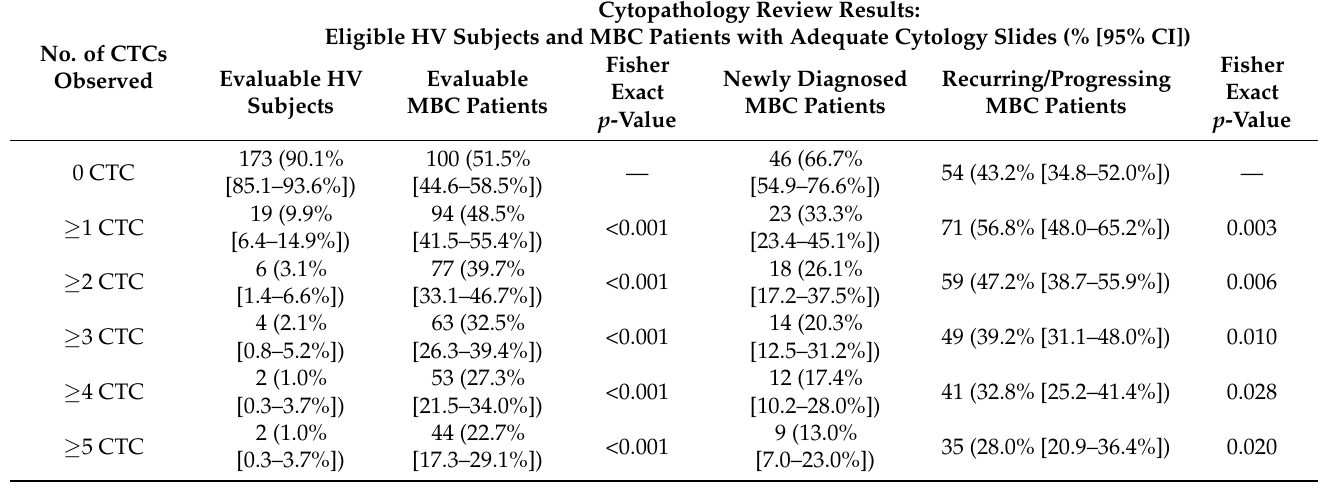
Table 3. Summary of CTCs from review of evaluable Wright-Giemsa stained cytology slides from 192 HV subjects and 194 MBC